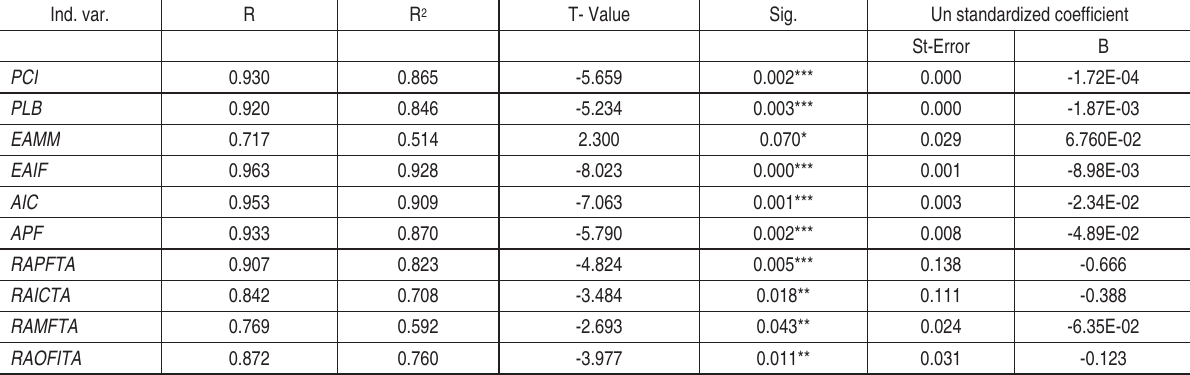
Table 5 indicated the regression analysis and the